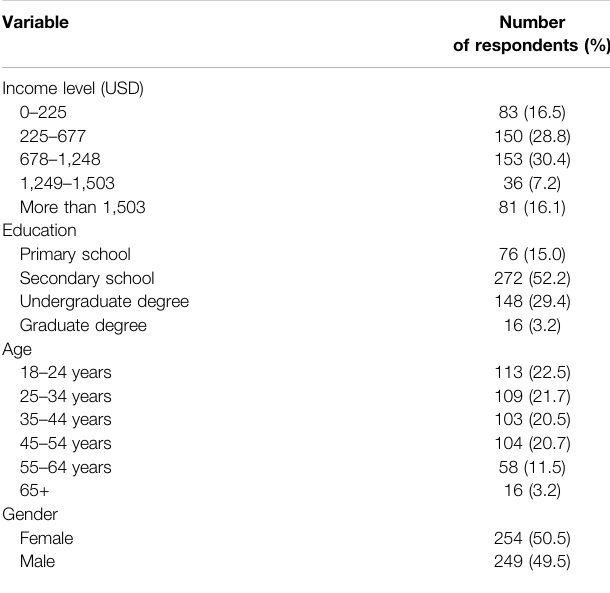
TABLE 2 | Demographic